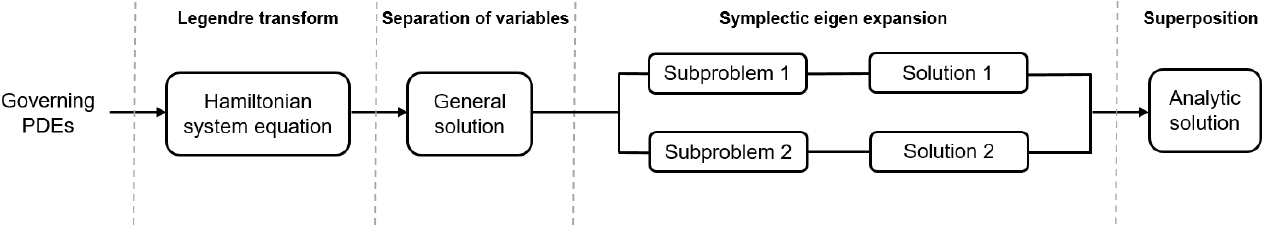
Figure 2. Flowchart of the solution procedure for the SSM.